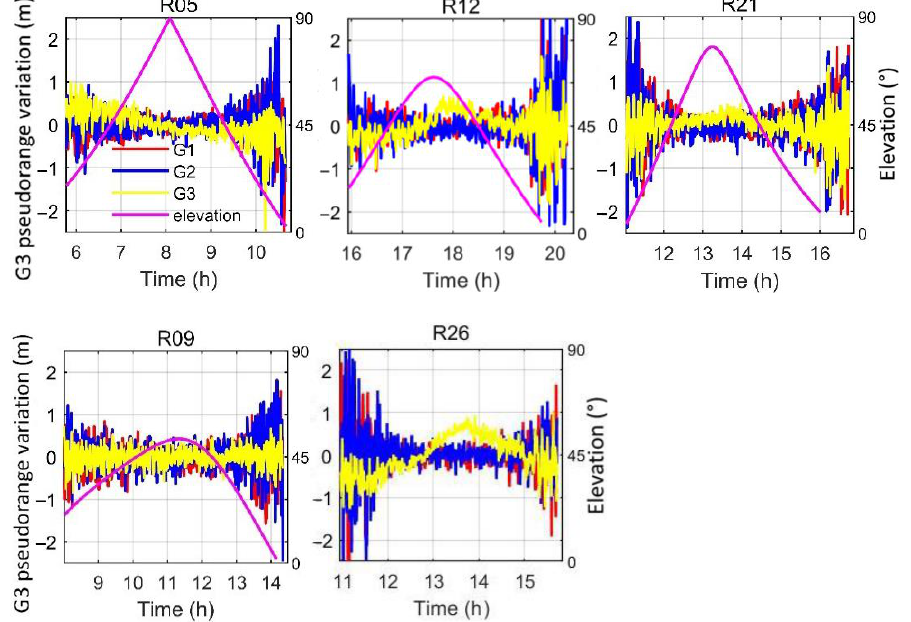
Figure 3. The relationship between the code pseudorange variations and elevation angle on DOY 325, 2020, at NNOR station. The red, blue, and yellow lines represent the code pseudorange variations on the G1, G2, and G3 frequencies, respectively. The purple line represents the elevation